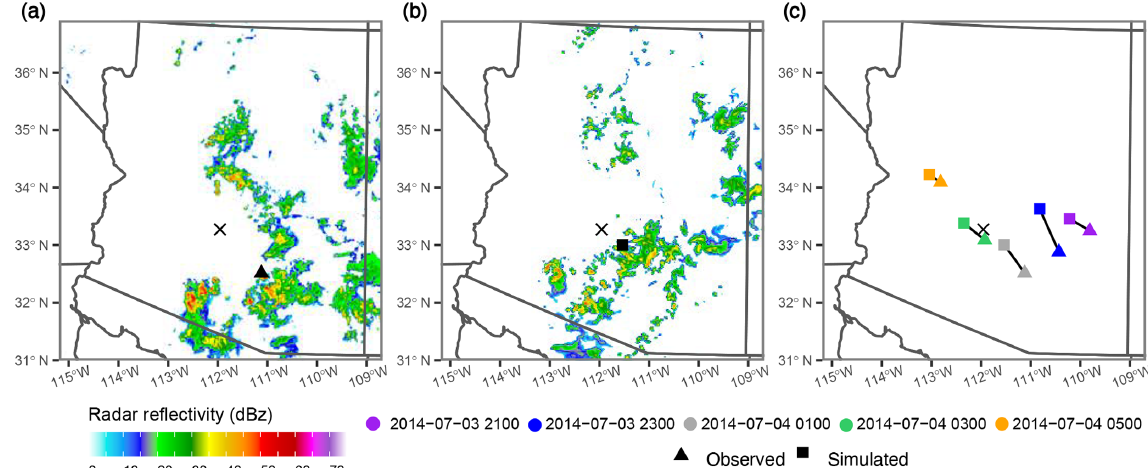
Figure 8. Observed and simulated radar reflectivity for 4 July 2014 at 01:00UTC, including an (a) observed composite radar image and (b) the model-simulated radar image. The black × marks the location of Phoenix, Arizona. Triangle and square markers indicate the location of a central point along the leading edge of the convective cell that affected Phoenix in the observed and simulated storms, respectively. The plot on the right (c) shows how these leading-edge central point locations evolved over time. Marker colors denote time in UTC.